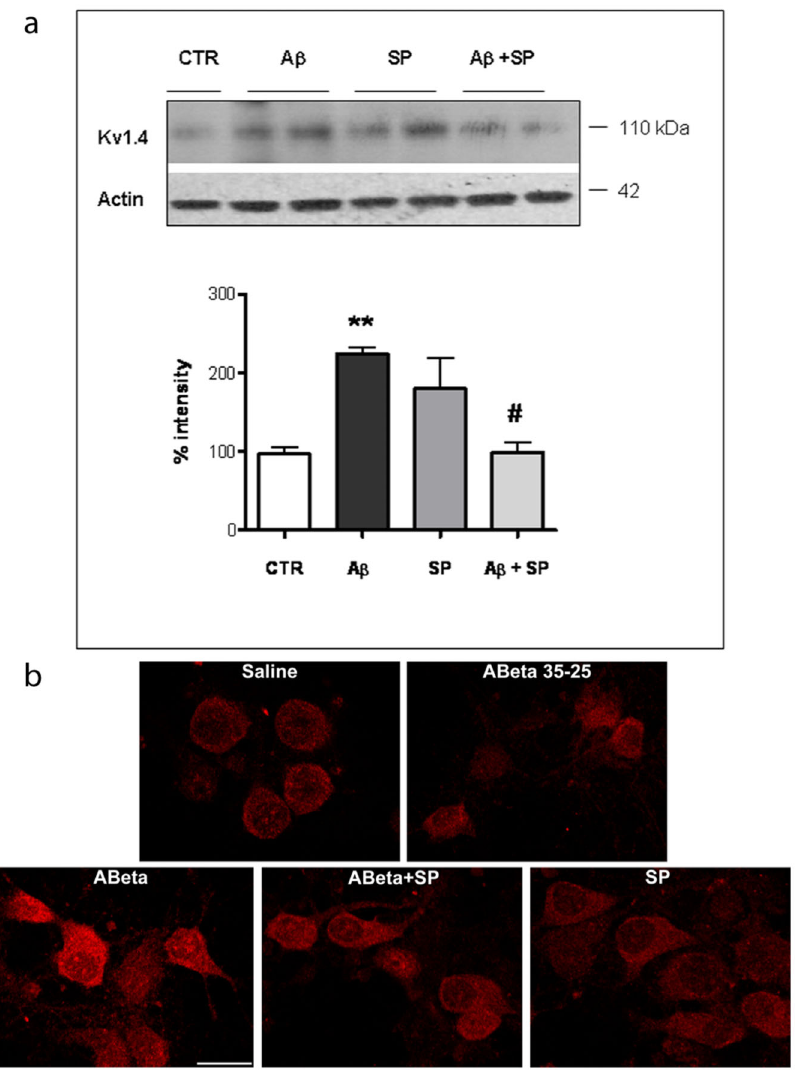
Figure 5. SP reduced A b 25–35-induced overexpression of Kv1.4 subunit in rat hippocampal neurons. a ) Example of Western blot obtained from hippocampal cultures exposed to 20 m M A b 25–35 (A b alone or in the presence of SP (100 nM) and analyzed 48 h later using a polyclonal antibody against Kv1.4 subunit. The same blots were stripped and reprobed with an antibody against b -actin as internal control (lower panels). Quantitative analysis is depicted below the blots and was determined by band densitometry analysis considering the values found in CTR cells as 100. Data represent means ( 6 S.E.M.) obtained from 4 independent experiments run in duplicate. (**p , 0.001 versus CTR, # p , 0.05 versus A b 25–35 treatment). b ) Representative immunofluorescence photomicrographs showing Kv1.4 expression in primary hippocampal cultures. Note the increase in immunofluorescence in the A b 25–35 neurons, as compared to control neurons, reversed by SP treatment. Images were obtained from three independent experiments. Scale bar: 20 m m.